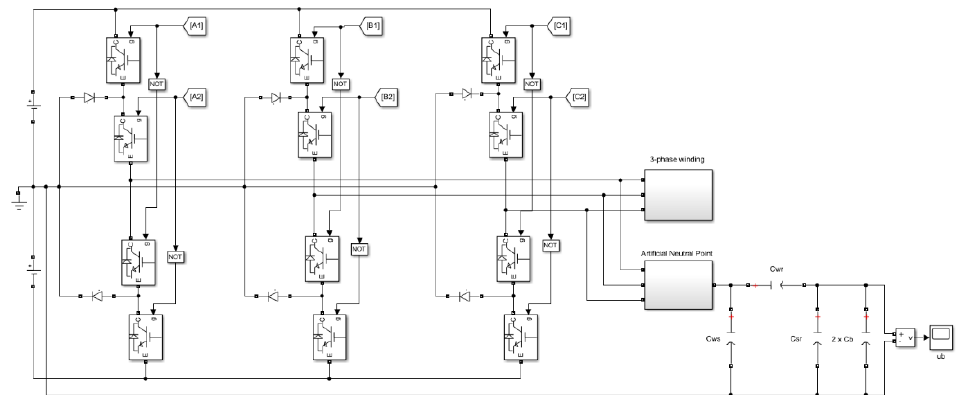
Figure 20. Simulation model with the three-level DC/AC converter.